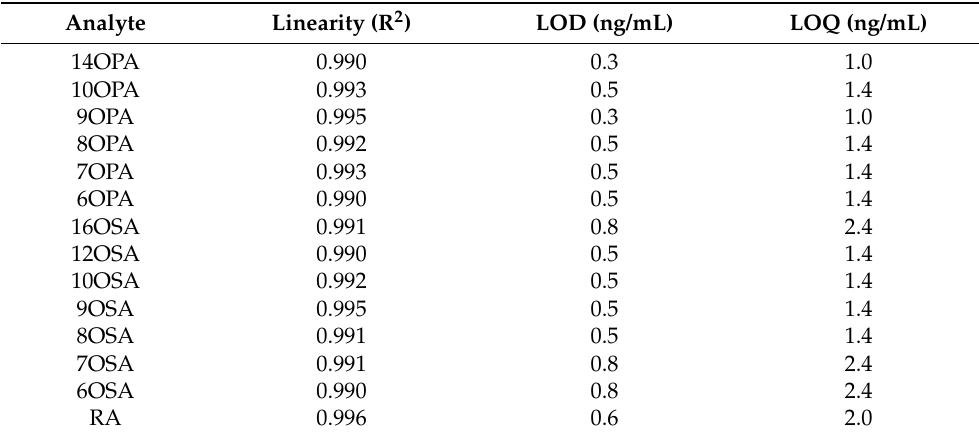
Calibration curve data and limits of detection (LOD) and quantification (LOQ) (range 5–500